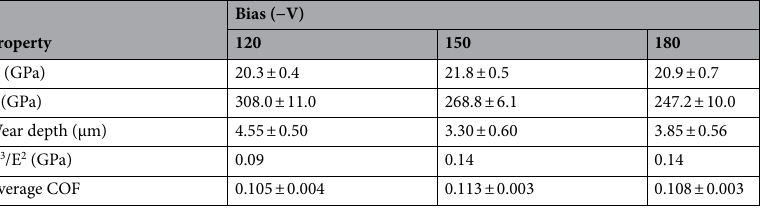
Table 1. Summary of H, E, wear against the cylinder liner, and H 3 /E 2 values obtained for CrN/Cr 1-x Al x